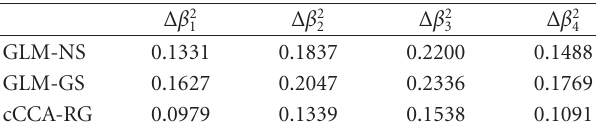
Table 1: Mean square errors (MSEs) of estimated coe ffi cients for di ff erent methods. To define di ff erent spatial patterns of activations, 100000 randomly shaped activations within a 3 × 3 grid of pixels having a size of 2 to 9pixels were generated. The corresponding time courses for the activated voxels were simulated to be linear combinations of the 4 random temporal regressors with random amplitudes. Di ff erent levels of noise were introduced by resampling 3 × 3 patches of resting-state fMRI data. The mean square errors between the originally simulated amplitudes of regressors and estimated ones are shown. The cCCA-RG method achieves more than 25% less MSE compared to GLM-NS. The GLM-GS method is worse than GLM-NS due to the small and irregularly defined activation patterns. Δ β 2 1